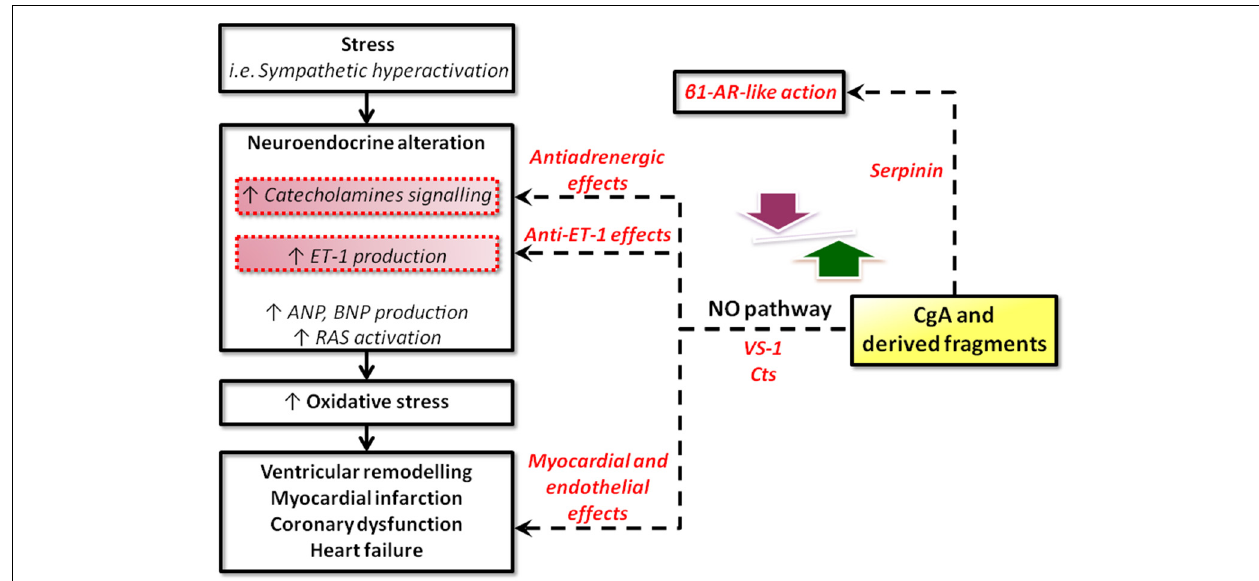
FIGURE 2 | Schematic representation of the possible sites for intervention of CgA and its derived peptides in heart failure. CgA and its fragments could operate at two, non-exclusive, levels: systemic and local. At the systemic level, CgA may work together with other factors (catecholamines, ANGII, cytochines, chemochines,